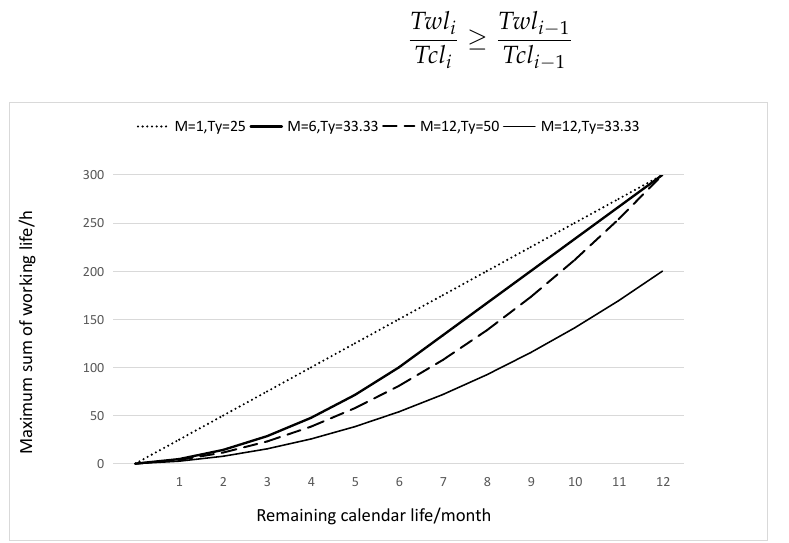
Figure 5. Maximum sum of working life.